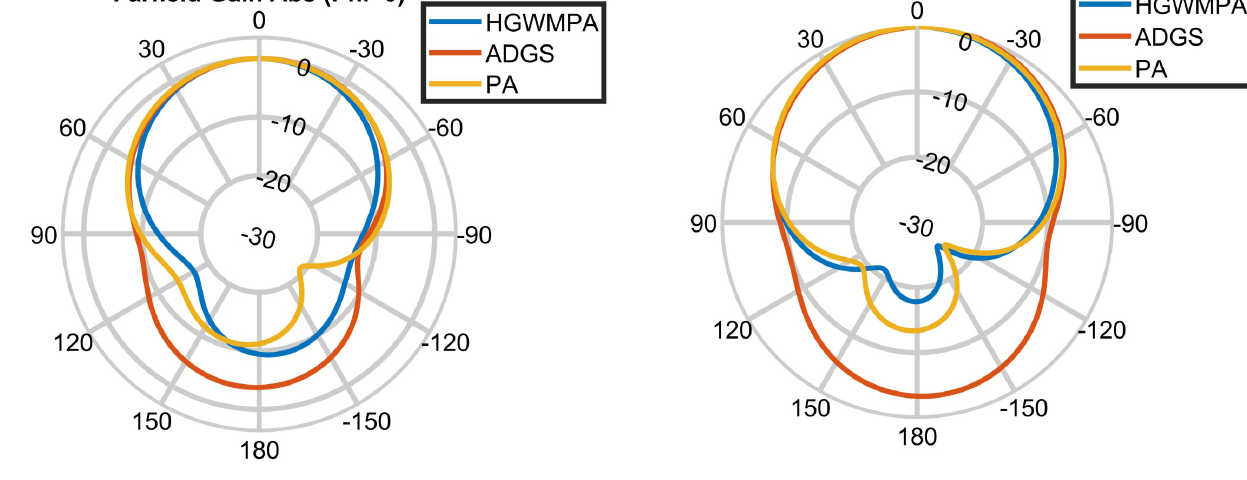
FIGURE 9. Normalized radiation patterns of the PA, ADGS and HGWMPA at 5.4 GHz (Phi=0 deg.